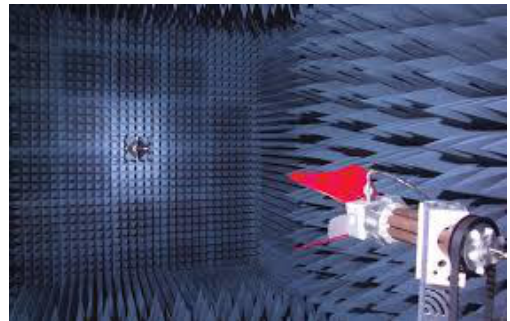
Figure 14. Photograph of the anechoic chamber.